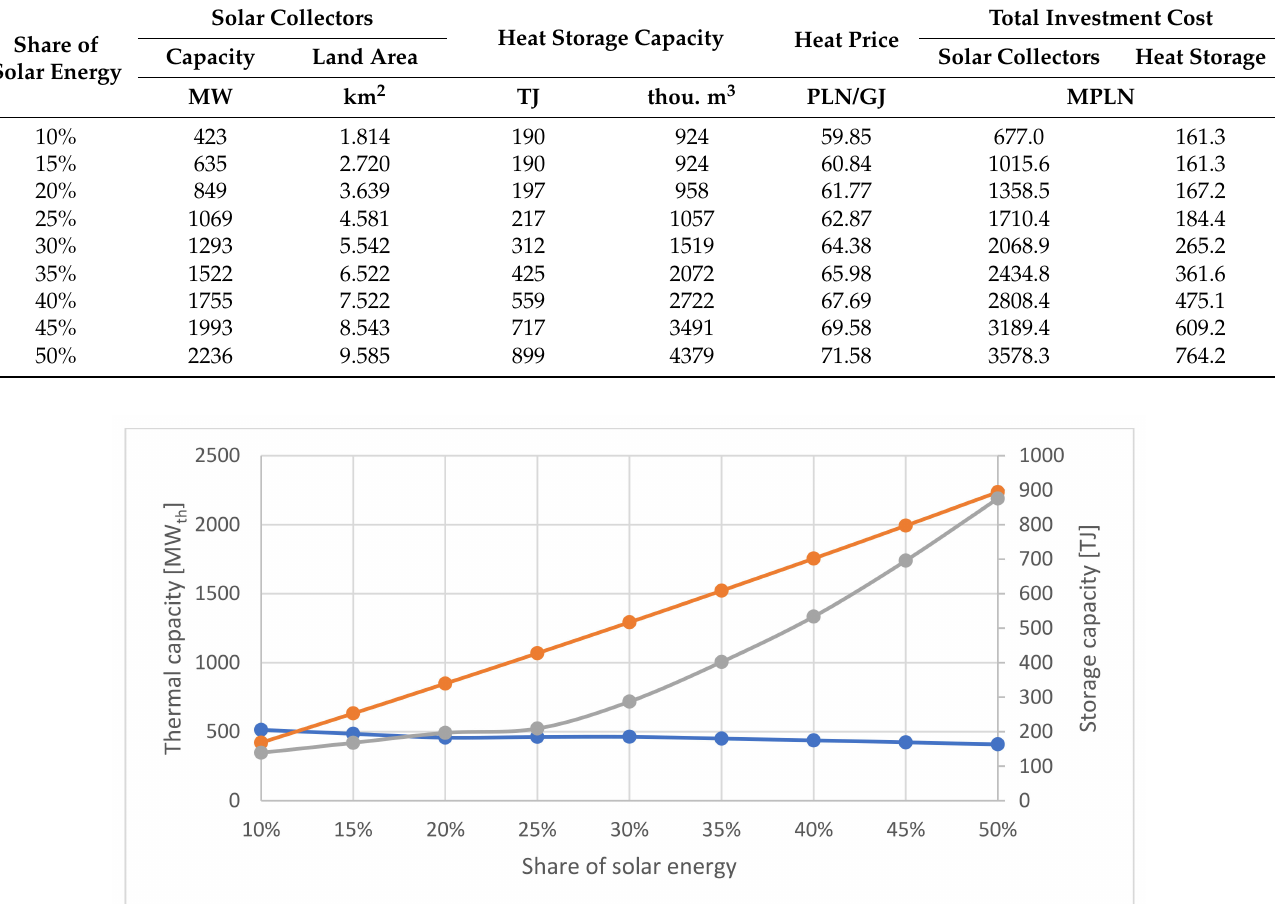
Table 13. Summary of the basic results of the STAT scenario depending on the required share of solar energy in heat generation.